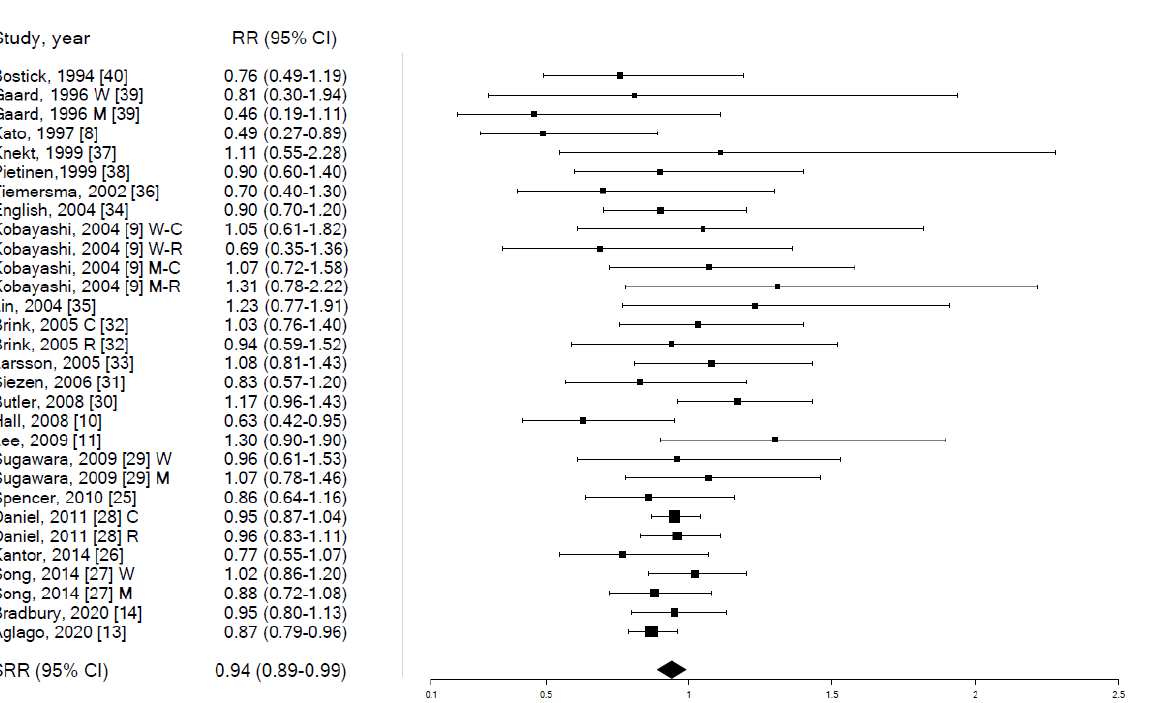
Figure 2. Forest plot for the association between fish consumption (highest vs. lowest category of consumption) and colorectal cancer risk. RR: relative risk. SRR: summary relative risk. CI: confidence intervals. W: RR among women. M: RR among men. C: RR for colon cancer. R: RR for rectal